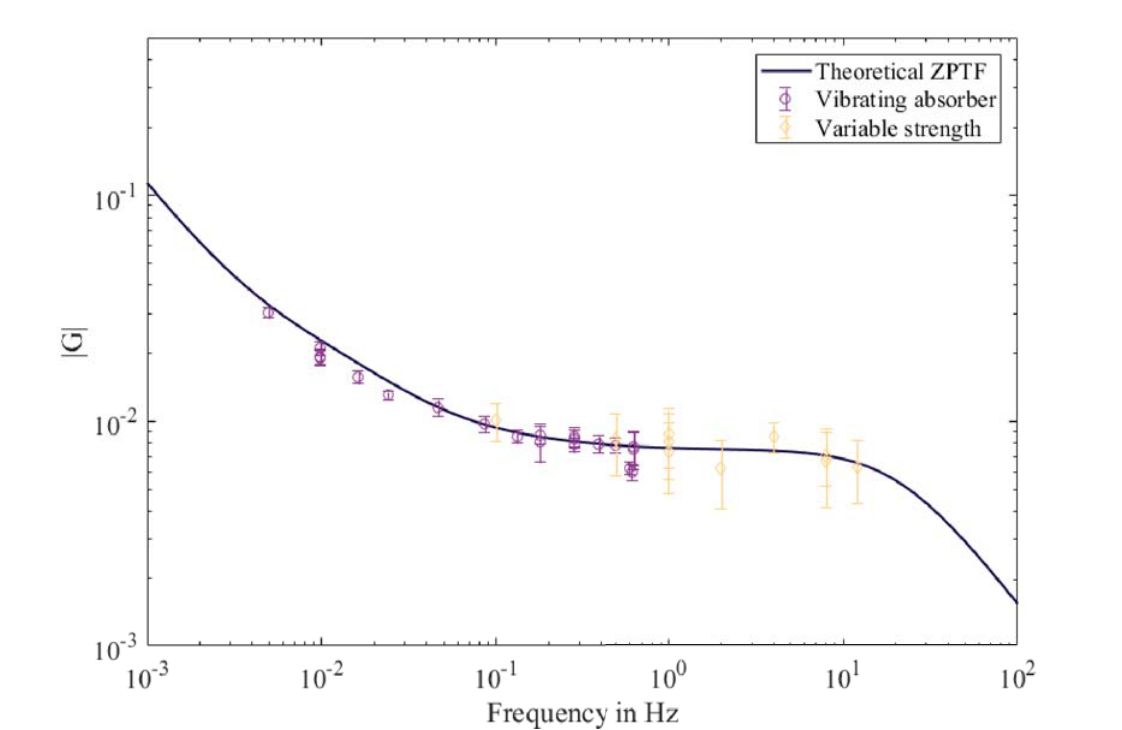
Figure 6. Comparison of the measurements and the theoretical shape of the